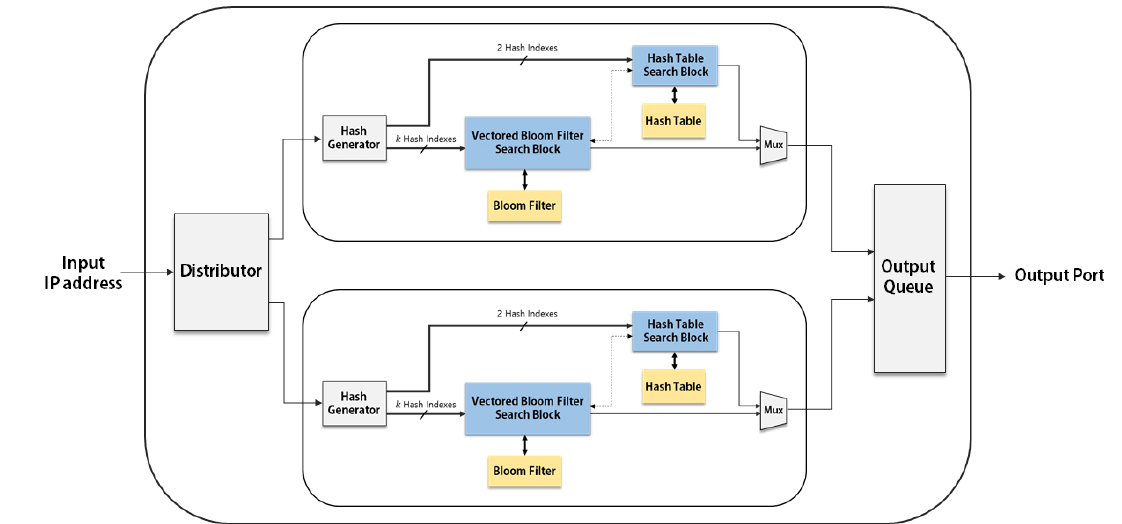
Figure 4. Parallel architecture consisting of two basic IP address lookup modules: the bold lines represent data paths and the dotted lines represent control